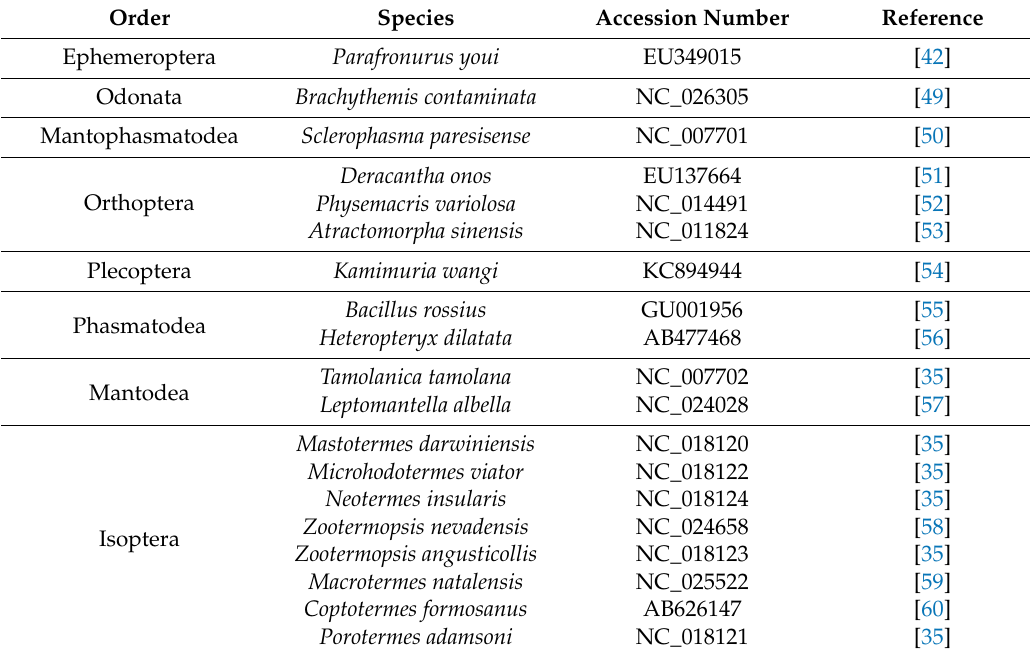
Table 4. GenBank accession numbers of taxa used to reconstruct phylogenetic